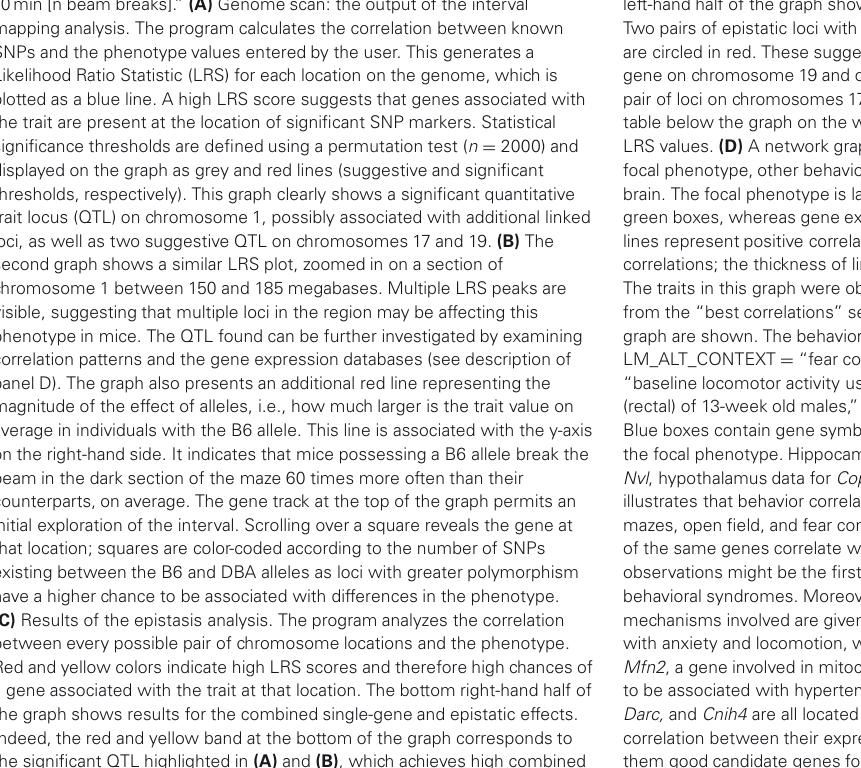
gene on chromosome 19 and one on chromosome 3 and between a second pair of loci on chromosomes 17 and 1. Significance threshold are given in a table below the graph on the website, and can be compared with a table of LRS values. (D) A network graph summarizing the interactions between the focal phenotype, other behavioral phenotypes, and gene expression in the brain. The focal phenotype is labeled ZM_ACTIVITY. Other phenotypes are in green boxes, whereas gene expression data is in blue boxes. Red and orange lines represent positive correlations, blue and green ones represent negative correlations; the thickness of lines indicates the strength of the correlation. The traits in this graph were obtained by selecting the top 10 unique traits from the “best correlations” searches, but only traits fully connected in the graph are shown. The behavior phenotypes displayed are: LM_ALT_CONTEXT = “fear conditioning response,” LOCACTGridDay2 = “baseline locomotor activity using grid test,” Rtemp = “body temperature (rectal) of 13-week old males,” SalACT = “locomotion after [saline] injection.” Blue boxes contain gene symbols for which gene expression correlates with the focal phenotype. Hippocampus gene expression was used for Cnih4 and Nvl , hypothalamus data for Copa, Mfn2, Darc and Ildr2 . Firstly, this graph illustrates that behavior correlates in a number of contexts, including zero mazes, open field, and fear conditioning. Importantly, it also shows that some of the same genes correlate with many behavioral phenotypes. These two observations might be the first step towards an in-depth genetic analysis of behavioral syndromes. Moreover, some intriguing potential clues to the mechanisms involved are given. For instance, rectal temperature correlates with anxiety and locomotion, which in turn correlate with the expression of Mfn2 , a gene involved in mitochondrial function and metabolism, and known to be associated with hypertension. Finally, it should be noted that Copa, Darc, and Cnih4 are all located in the QTL interval on chromosome 1, and the correlation between their expression and the focal anxiety phenotype makes them good candidate genes for the behavior measure